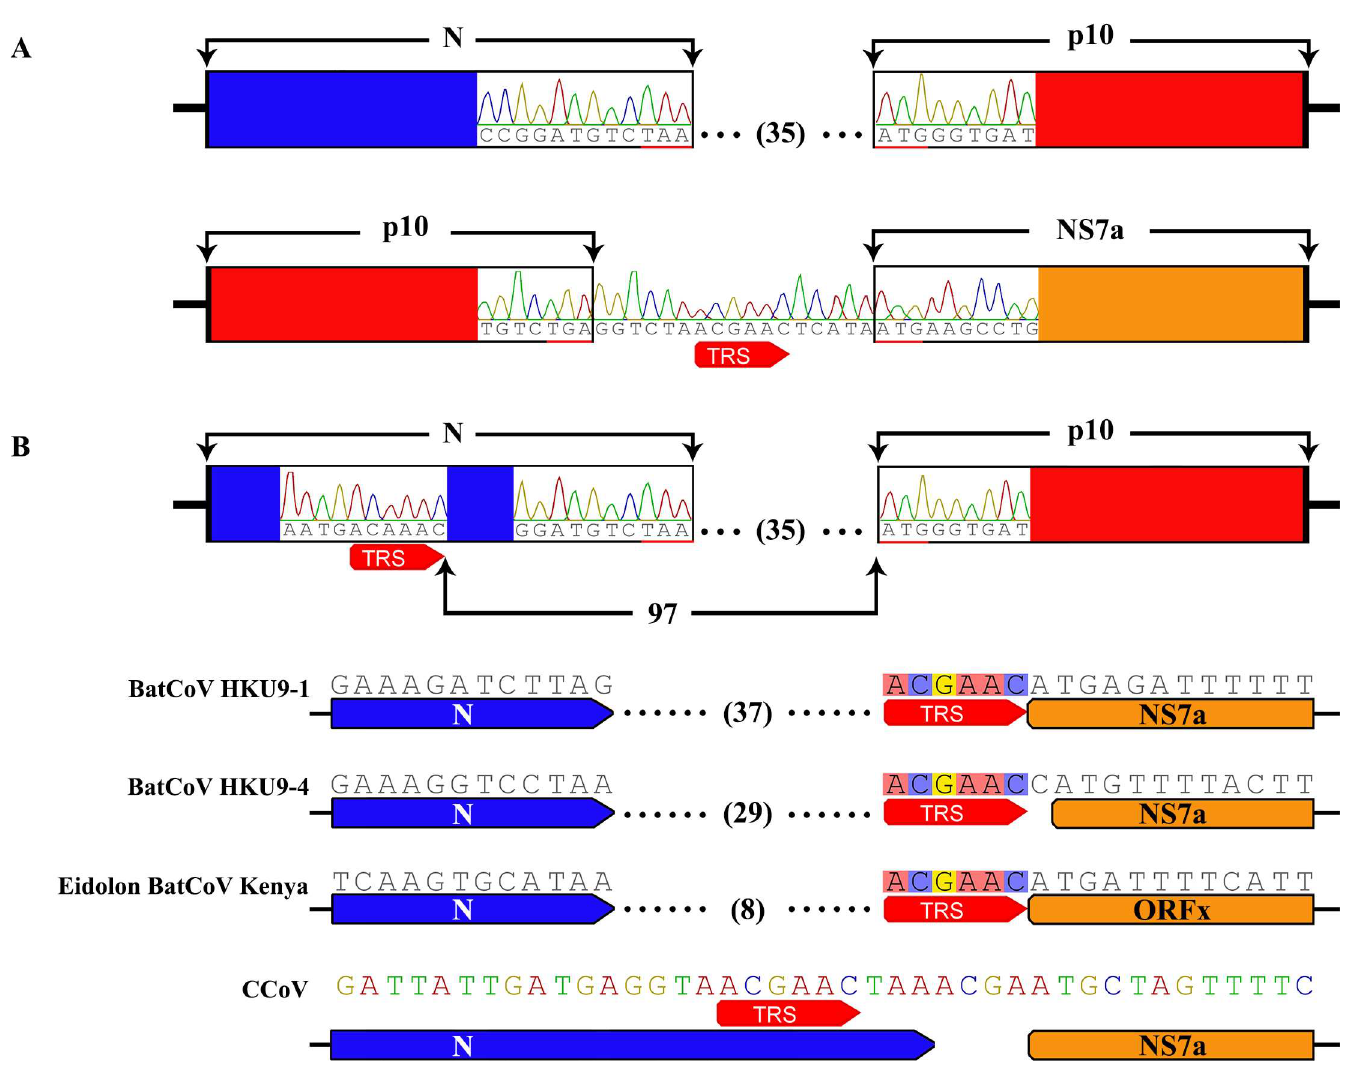
Fig 4. Identificationof the recombinant p10 geneand its TRS. (A) Confirmation of the “exotic” p10 gene. The sequencesthat cover the upstream junctionsite betweenthe N and p10 genes, and downstream junctionsite between the p10 and NS7a genes, are illustratedwith sequencingpatterns. The length of the intergenic sequence between the N and p10 genes is indicated with a number. The TRS preceding the NS7a gene in the intergenicsequence is markedwith red arrow. (B) Identificationof the TRS of the p10 gene. The TRS of the p10 gene in the N gene is illustratedwith a sequencing pattern.The distancefromthe TRS to the AUG codon of p10 gene is indicatedwith a number. The length of the intergenic sequencebetween the N gene and genes just downstream of N gene are indicated with numbers. The TRSs of genes just downstream of N gene are marked with red